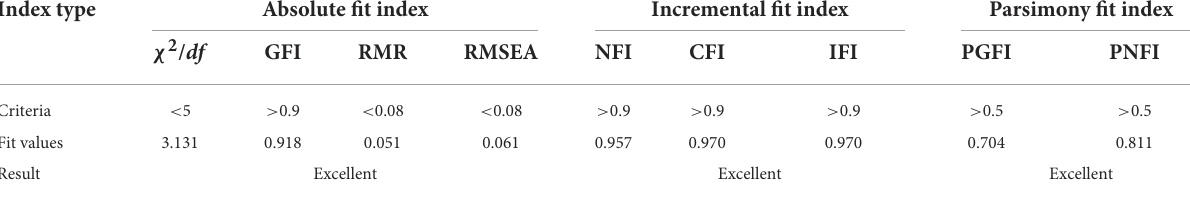
TABLE 5 Model fit criteria and the test results.